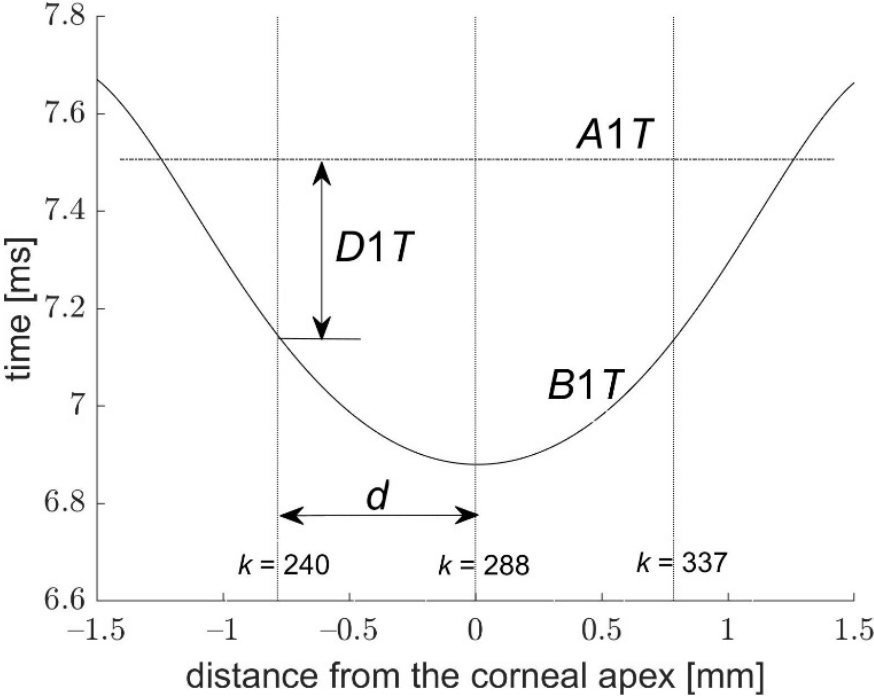
Figure 4. Times B 1 T and D 1 T as a function of the distance from the corneal center; d —the distance where the slope variations were analyzed.